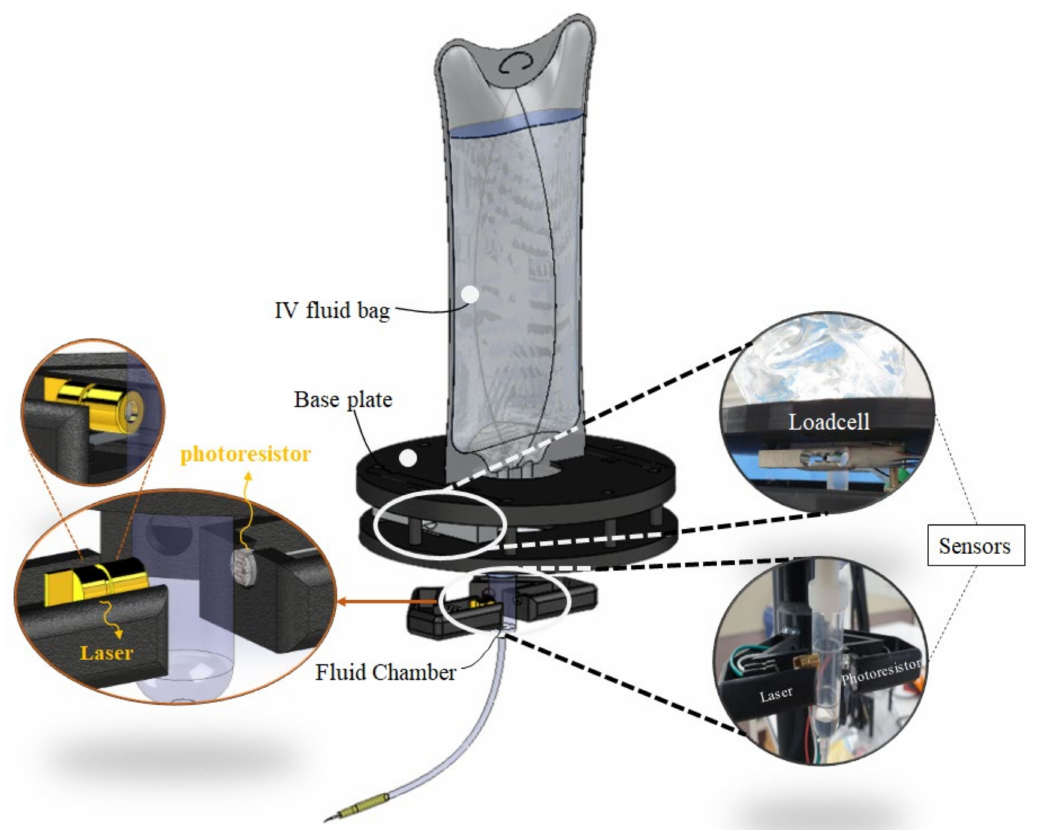
Figure 4. Body design and actual